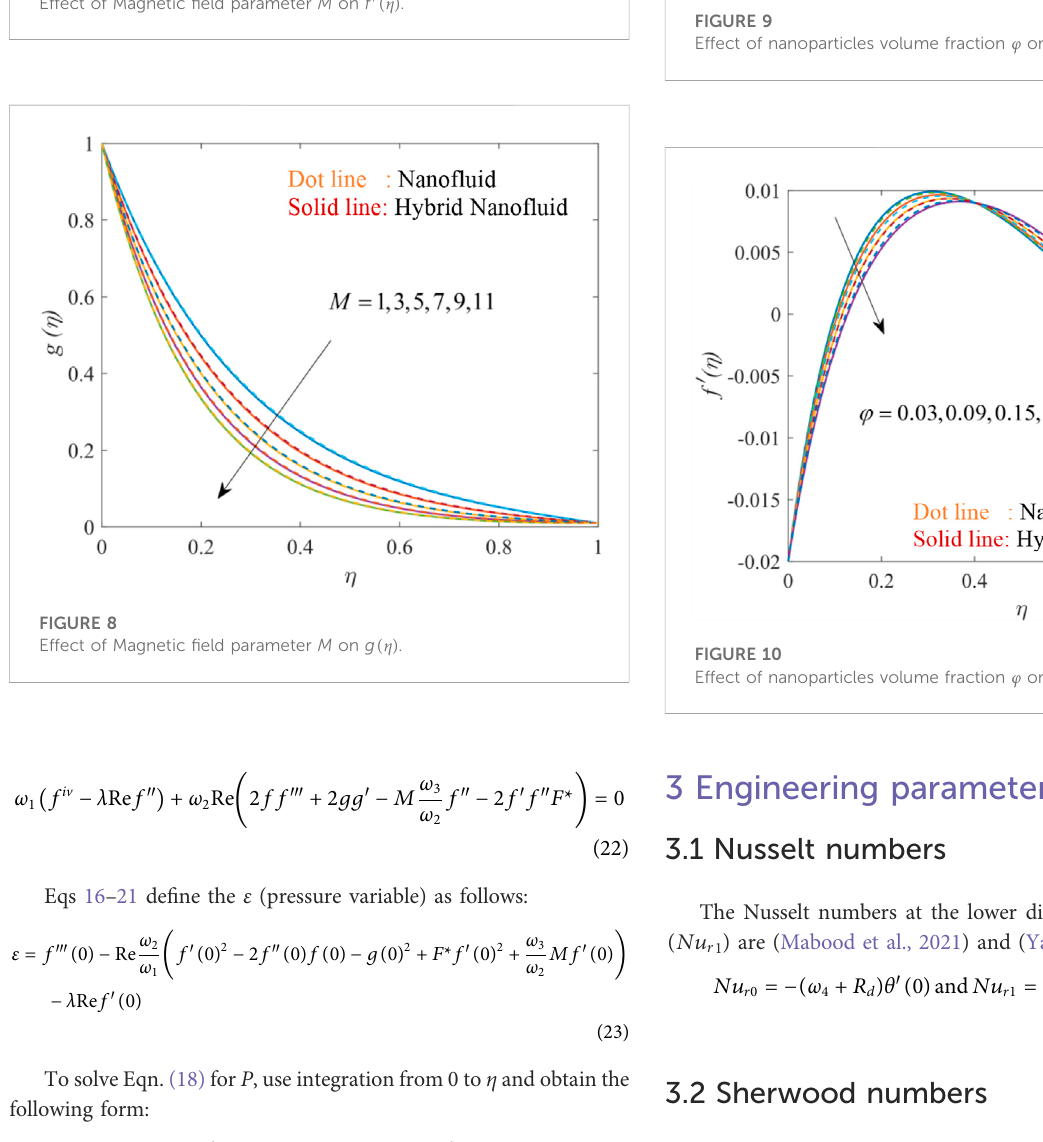
FIGURE 7 Effect of Magnetic fi eld parameter M on f ′ ( η ) .